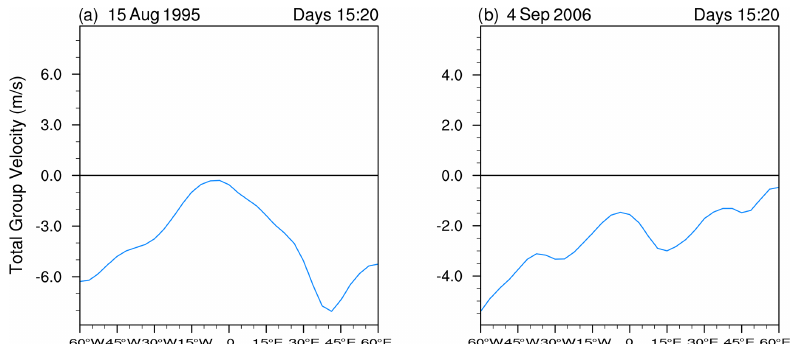
Figure 16. Total group velocity (ms − 1 ) averaged over days 15–20 of the simulations for the 15 August 1995 basic state (a) and the 4 Septem- ber 2006 basic state (b)